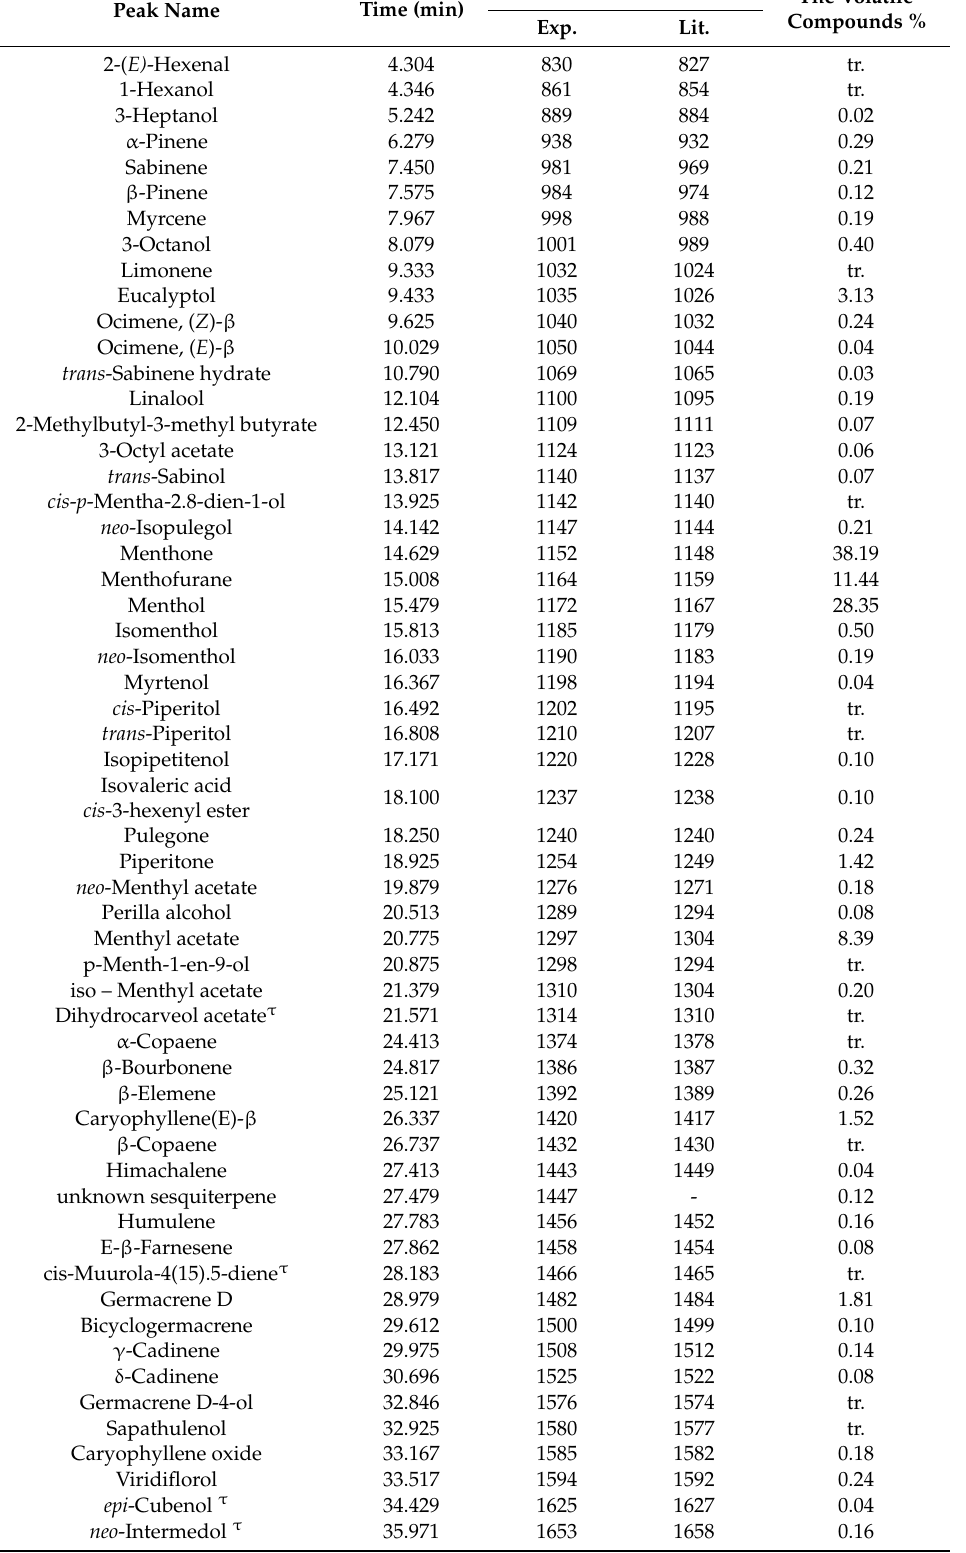
Table 1. Chemical composition of peppermint